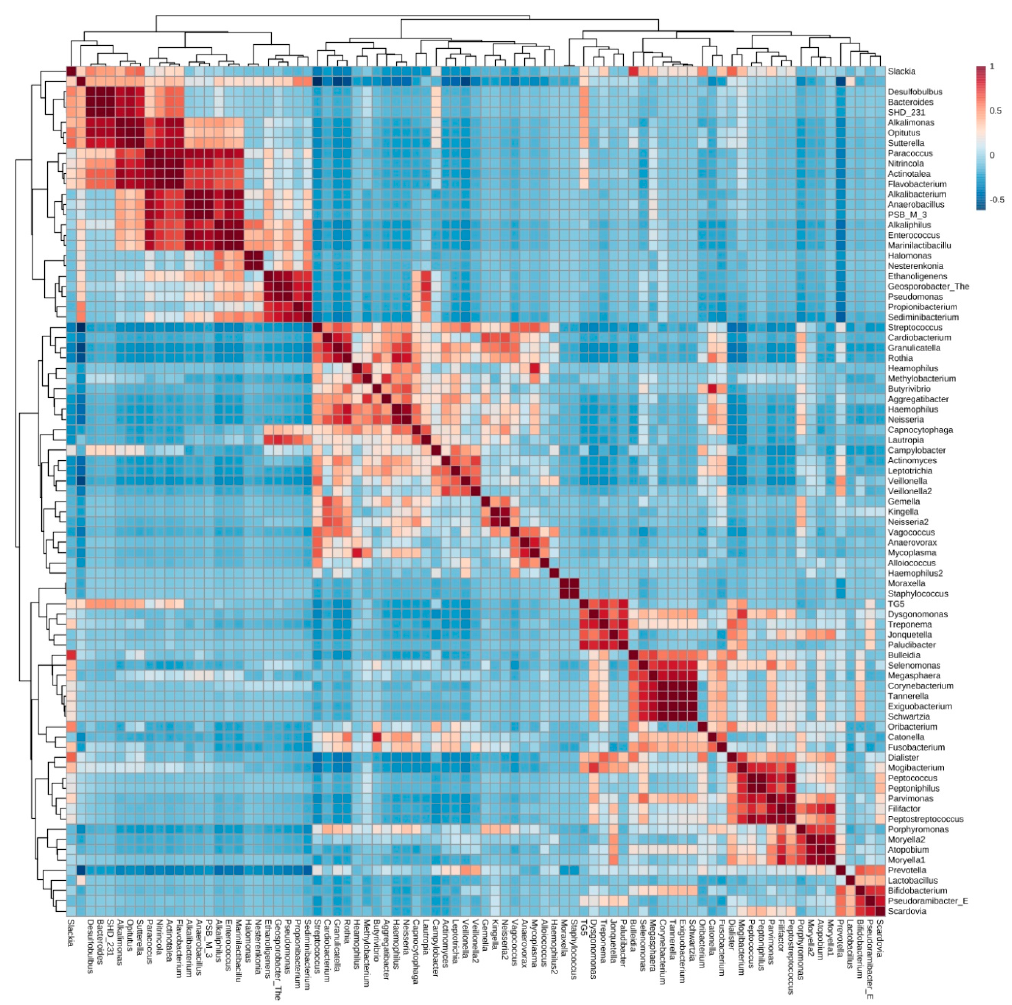
Figure 2. PearsonR correlated heatmap of bacterial genera in endodontic infections, highlighting distinct positive and negative correlations and categorical clusters between genera , defining the population composition and potential niche redundancies between closely related taxonomic groups. Scale represents correlation coefficients (+1 to − 1). A high-resolution image of the present figure is provided in the online version of this manuscript.